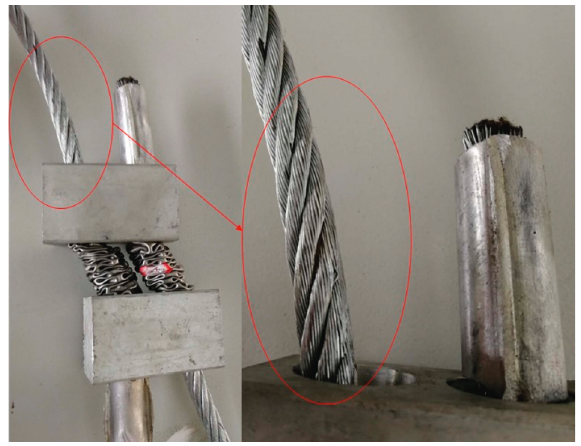
Figure 20: Abrasion of steel cables for tube-crushing dissipators after